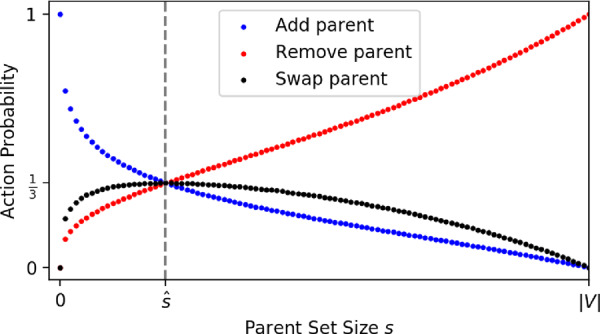
Action probabilities as a function of parent set size. The reference size s^ is determined from prior knowledge. It approximates the size of a ‘typical’ parent set. When s<s^, add-parent is most probable; when s>s^, remove-parent is most probable; and when s=s^, all actions have equal probability